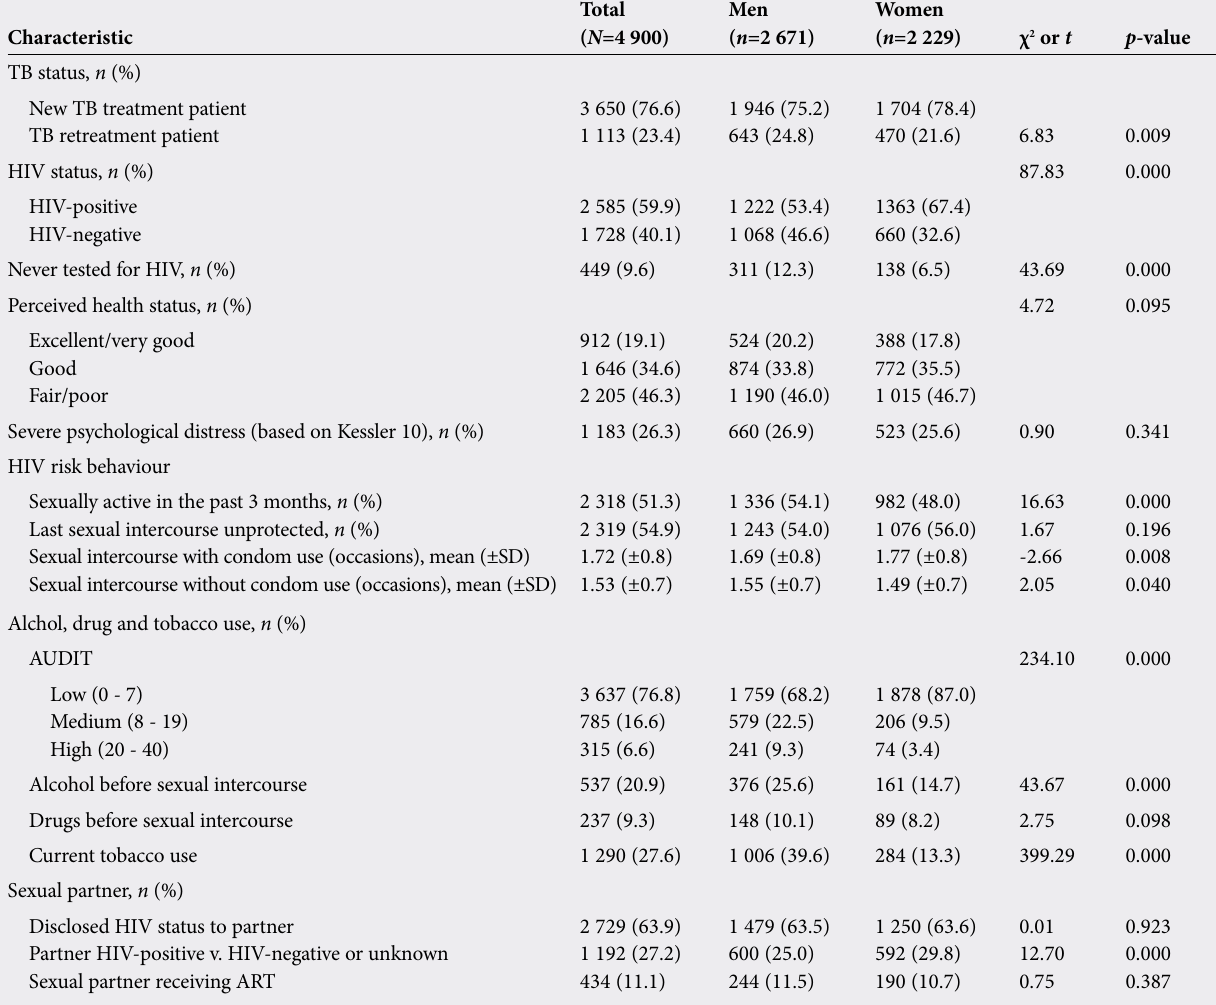
Table 2. Health and HIV risk characteristics